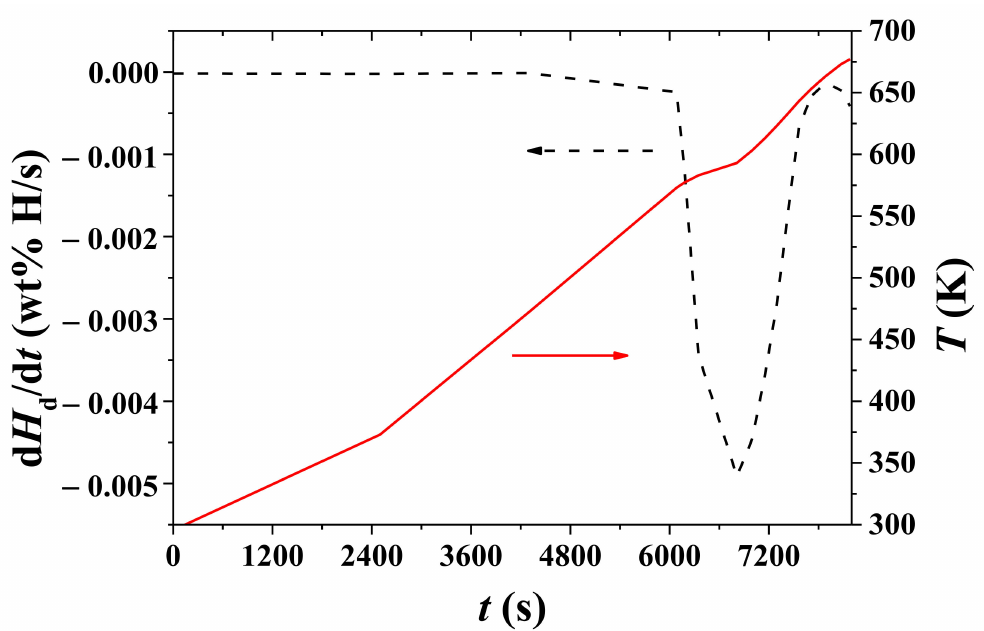
Figure 7. Variations with time, t , of temperature, T , and the rate of H d change, d H d /d t , under 1.0 bar H 2 for hydrided Mg–5Ni. The sample was heated with a heating rate of 3 K/min. Figure 8 shows variations with time, t, of T and the d H d /d t under 1.0 bar H 2 for hydrided Mg–5Ni. The sample was heated with a heating rate of 9 K/min. As time elapses, the temperature increases, and a plateau appears after about 2570 s. After 3400 s, the temperature increases very slowly. The rate of H d change begins to increase after 2441 s (586.6 K) and becomes very low after 3400 s. The rate of H d change, d H d /d t , is the highest at 2570 s (606.3 K).